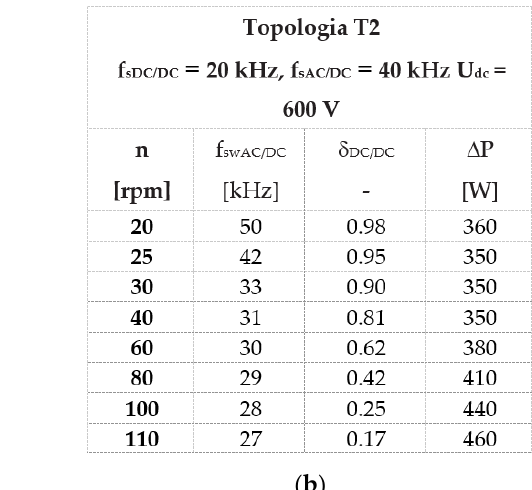
Figure 10. ( a ) Power losses in the converter system of the topology T1 at different voltages in the DC circuit and ( b ) switching frequency f sw of the transistors in both converters at U dc = 600 V.